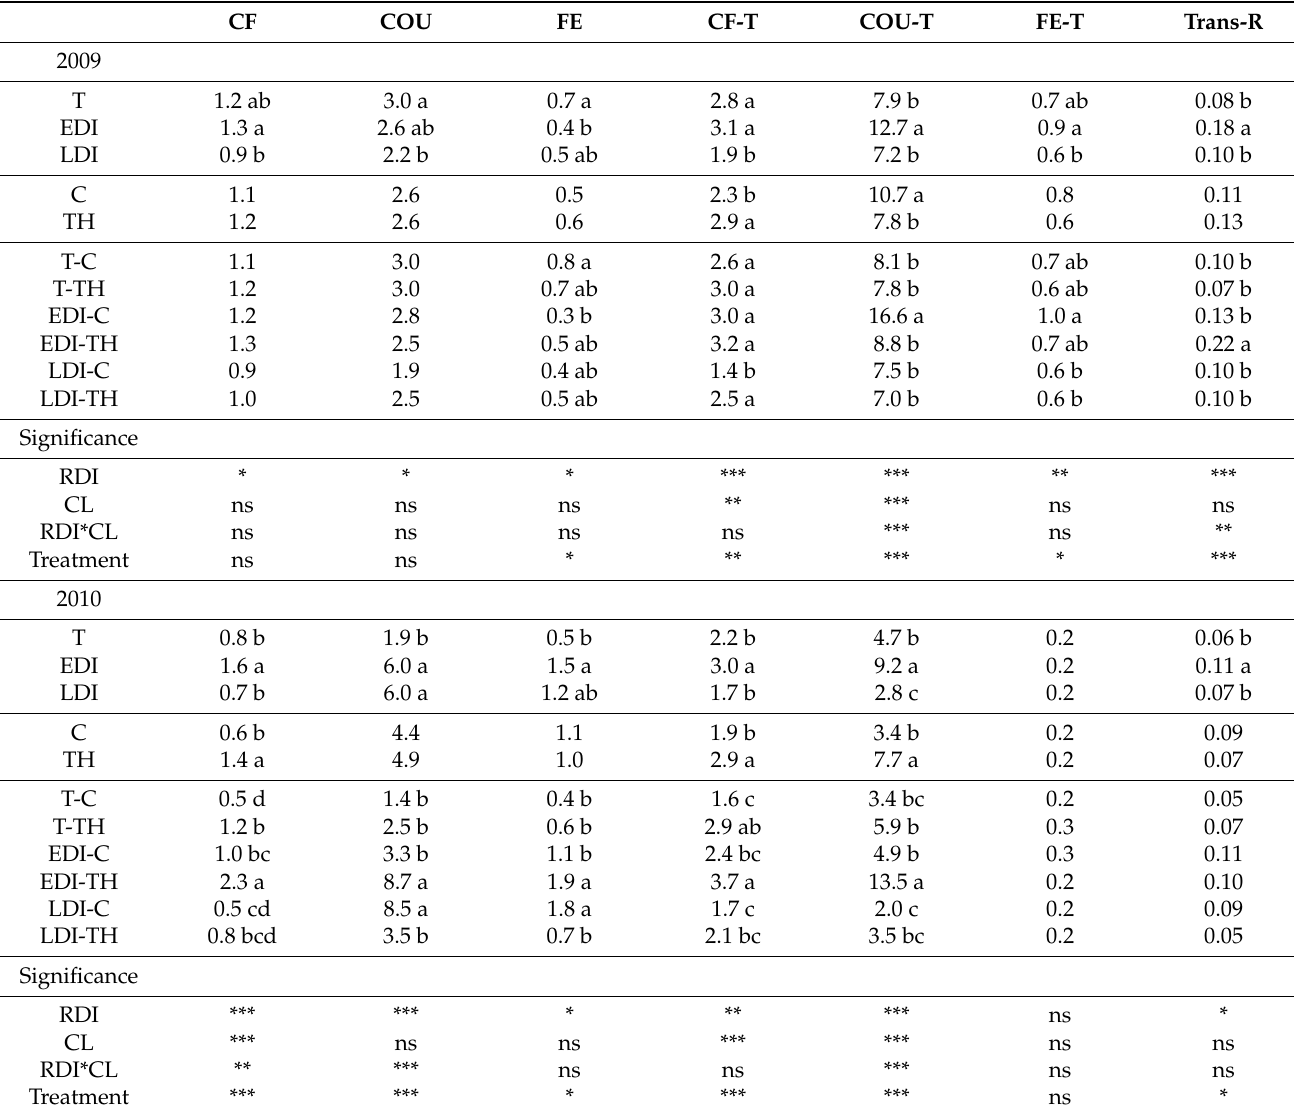
Table 4. Effects of regulated deficit irrigation and cluster thinning on grape skin